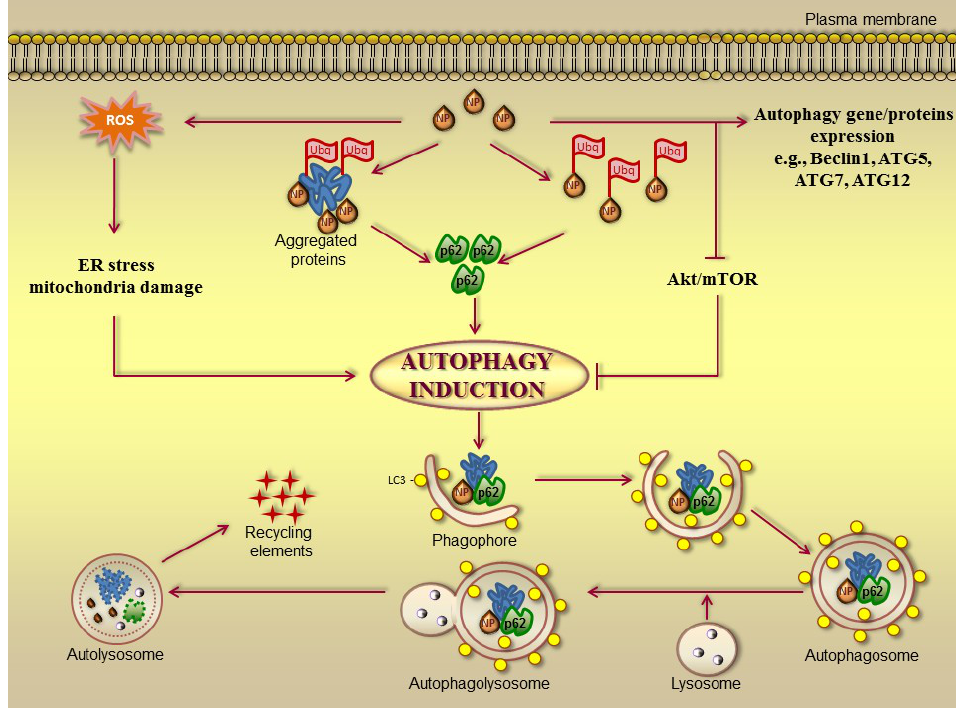
Figure 3. Nanoparticle-induced autophagy (adapted from